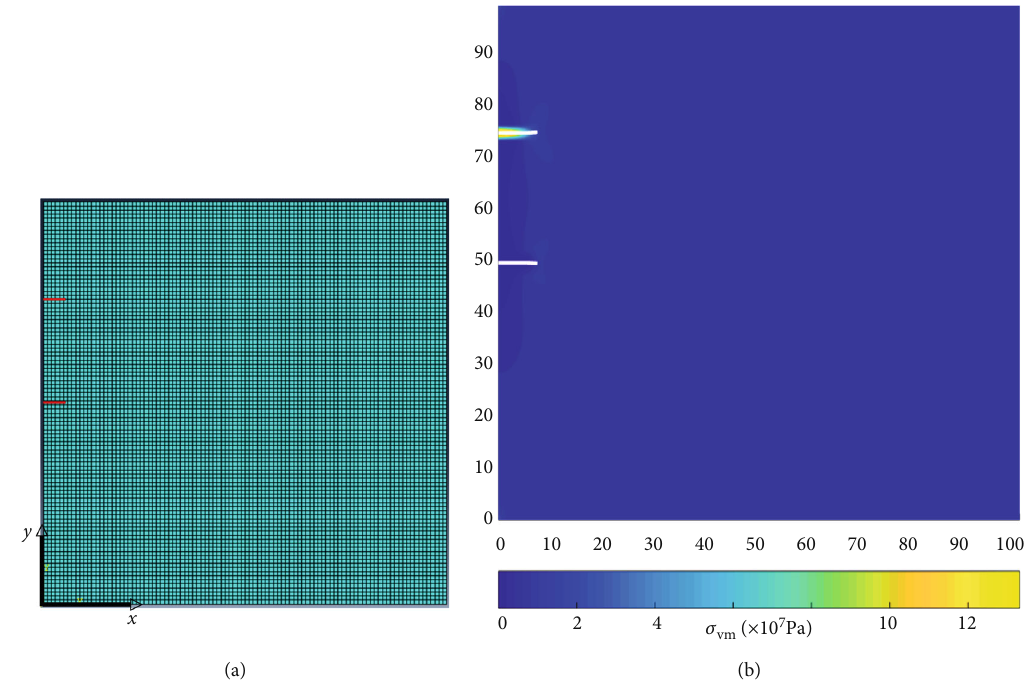
Figure 8: Results of the two-crack example, case 1: (a) mesh; (b) shaded plot of the von Mises stress σ